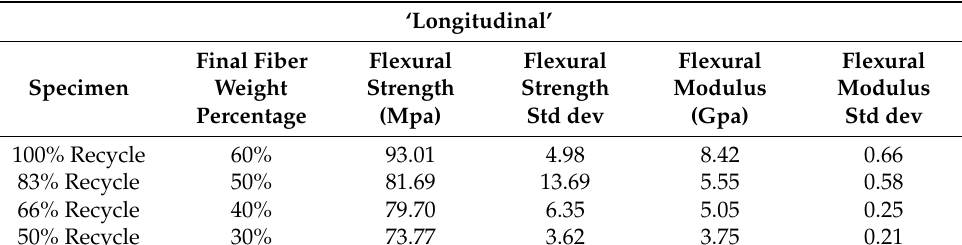
Figure 13. The 30% perpendicular LFT sample has more fibers aligned in the loading direction compared with the 30% parallel LFT sample.